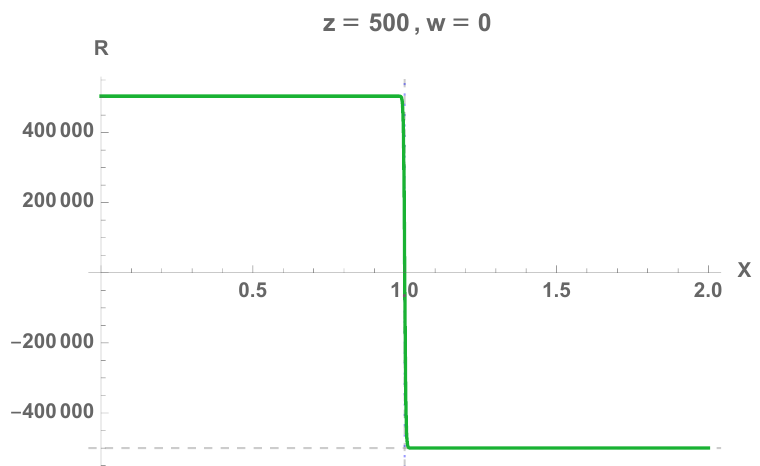
Figure 5: Ricci scalar approaches sign function with jump localized at